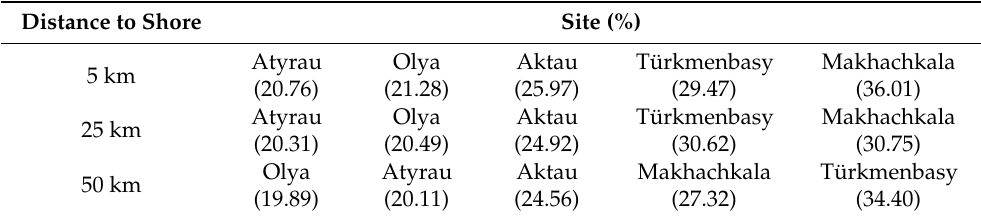
Table 3. The top five downtimes sorted in an ascending order (corresponding to a 3 m/s cut-in value).